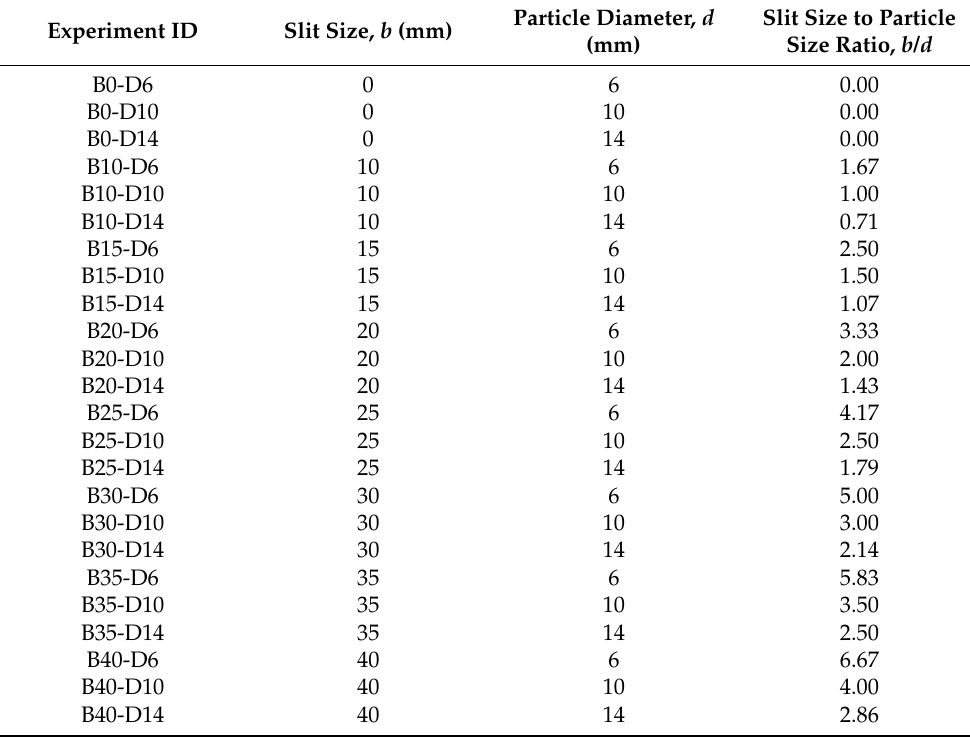
Table 3. Flume experiment